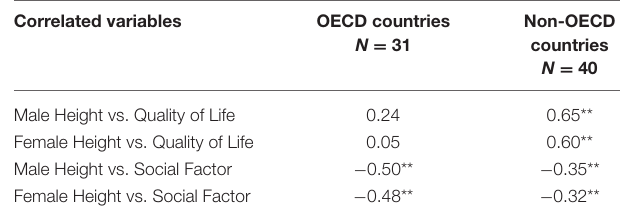
TABLE 3 | Pearson’s correlation coefficients of male and female height as a function of Quality of Life (QoL) and the social factors for the 31 member countries of the Organization for Economic Co-operation and Development (OECD) and the 40 non-OECD countries. Correlated